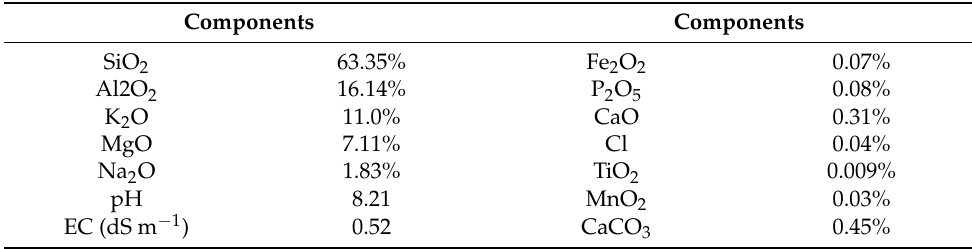
Table 2. Chemical composition of K-feldspar used in the experiment during the 2018 and 2019 growing